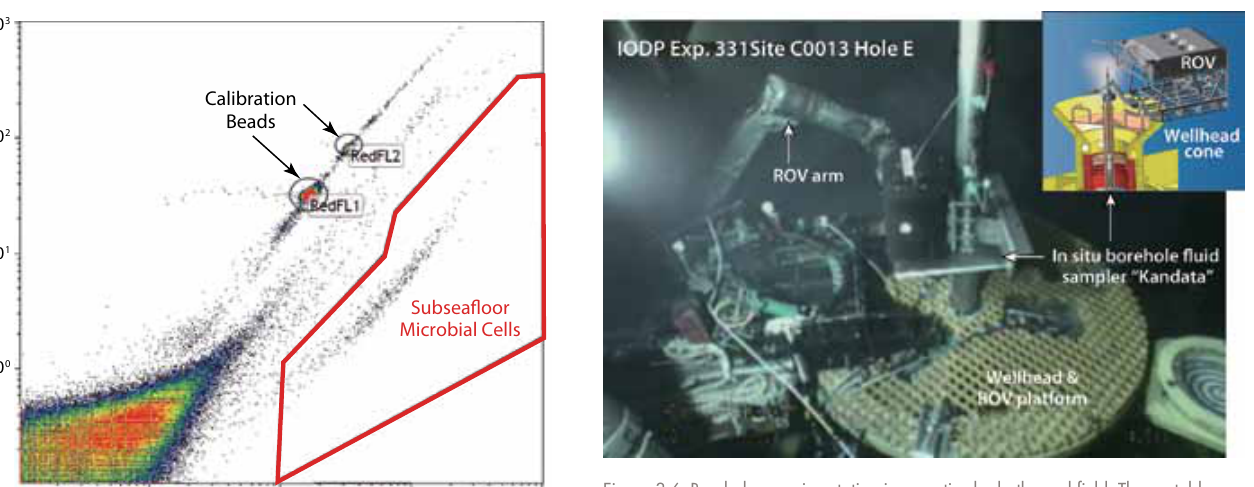
figure 3.6. Borehole experimentation in an active hydrothermal field. The portable in situ borehole fluid sampler “Kandata” was deployed in the okinawa Trough hydrothermal field during iodp expedition 331. after drilling with d/v Chikyu , the borehole was cased to 40 m below the seafloor, and high-temperature (>250°c) hydrothermal fluid began to discharge from the wellhead. inset: a schematic illustration of the “Kandata” operation at the cased and sealed borehole. The fluid sampler was hung in the borehole on a wireline by the rov HyperDolphin . The borehole fluid is captured to understand how fluid-mineral interaction, temperature, and flow rate affect habitability in the hydrothermal field. figure courtesy of K.